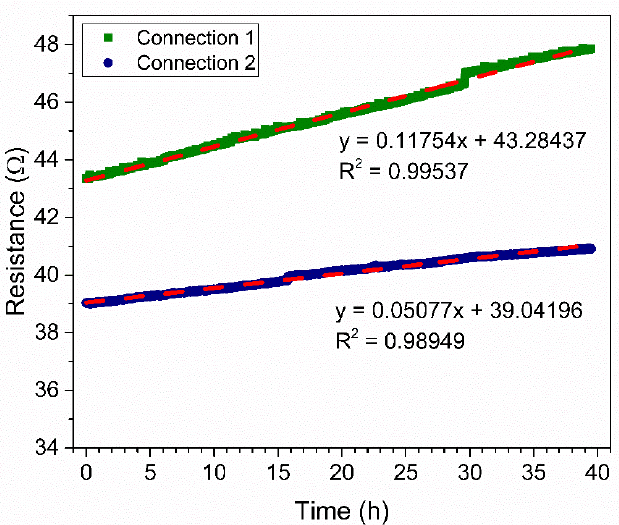
Figure 8. PANI-Au-SPE sensor stability at 70% of RH and room temperature (RT) for connection 1 (olive) and connection 2 (navy).